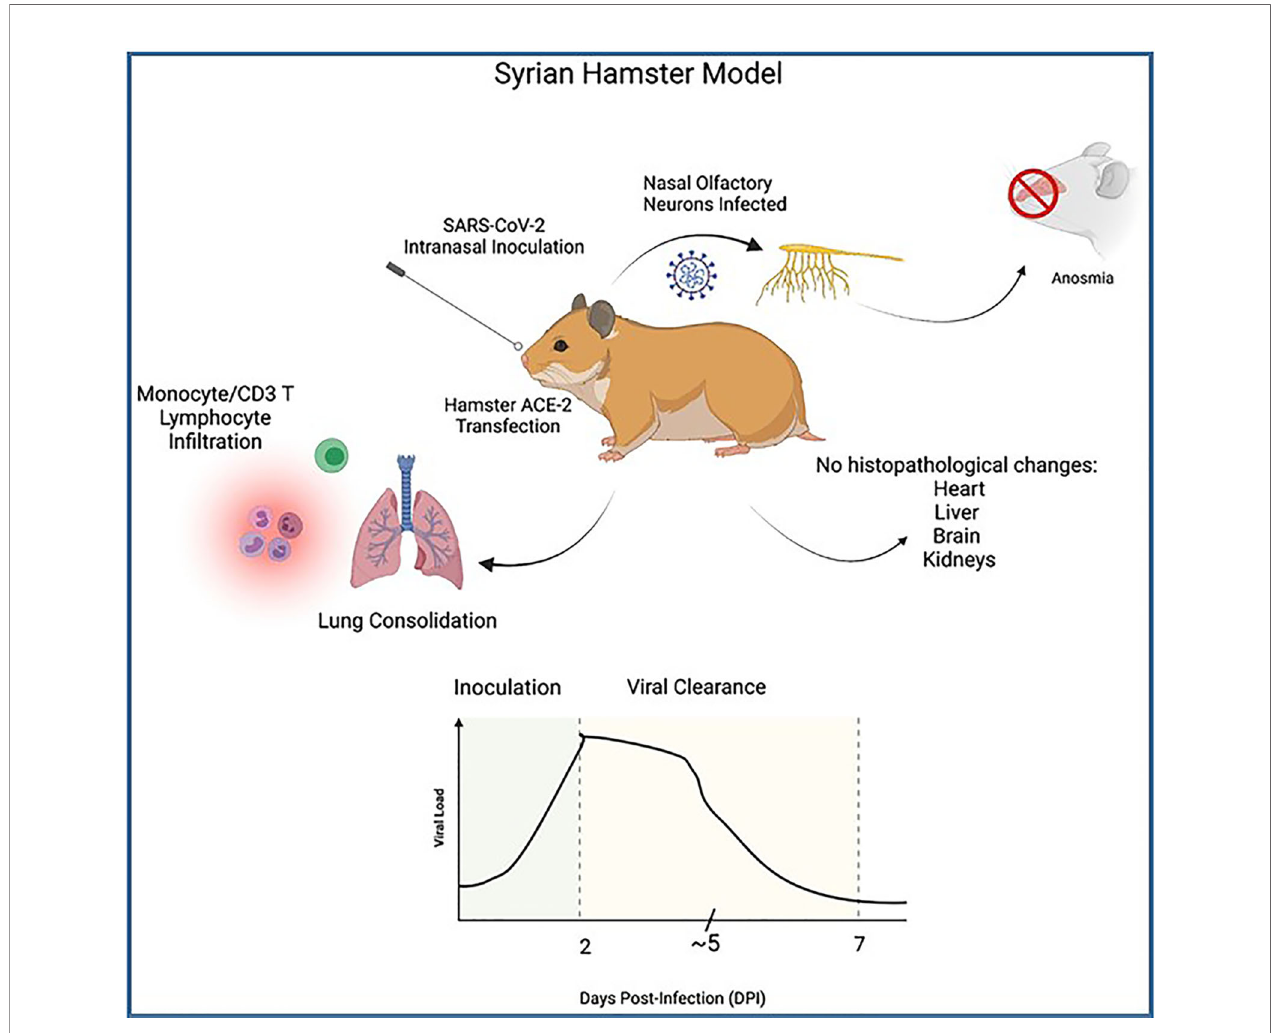
consolidation noted, however no histopathology was seen in extrapulmonary tissues despite viral antigen noted at duodenal and colon epithelia. Bottom: Graph illustrates viral course of SARS-CoV-2 infection in Syrian hamster model. High titers of viral RNA are noted 2 days post-inoculation (DPI), with steady decline of viral load 5 DPI and sharp decline and viral clearance at approximately 7